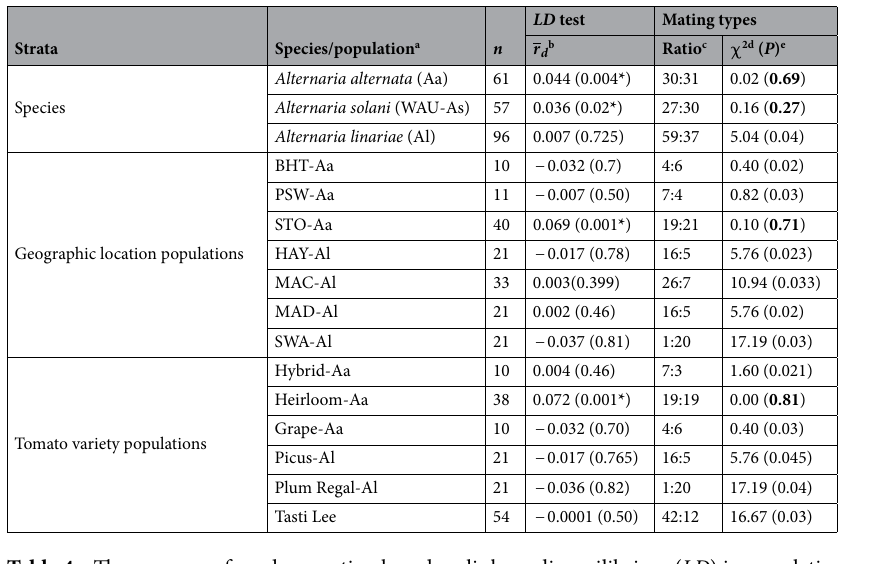
Table 4. The measure of random mating based on linkage disequilibrium ( LD ) in populations of three Alternaria species collected from different geographic locations and tomato and potato in North Carolina and Wisconsin using 220 single nucleotide polymorphisms (SNPs) from 10 microsatellite loci. The clone-corrected datasets were analyzed using poppr package R. a Populations of Alternaria spp. were defined in the methods. b r d = Standardized index of association 90 . Asterisks (*) indicate populations that are in linkage disequilibrium ( P ≤ 0.05). c Ratio of MAT1-1 : MAT1-2. d χ 2 = Chi-square values based on a 1:1 ratio and one degree of freedom. e P = Probability values in parentheses. P > 0.05 highlighted in bold indicate populations where the null hypothesis of random mating and mating types of 1:1 ratio was not